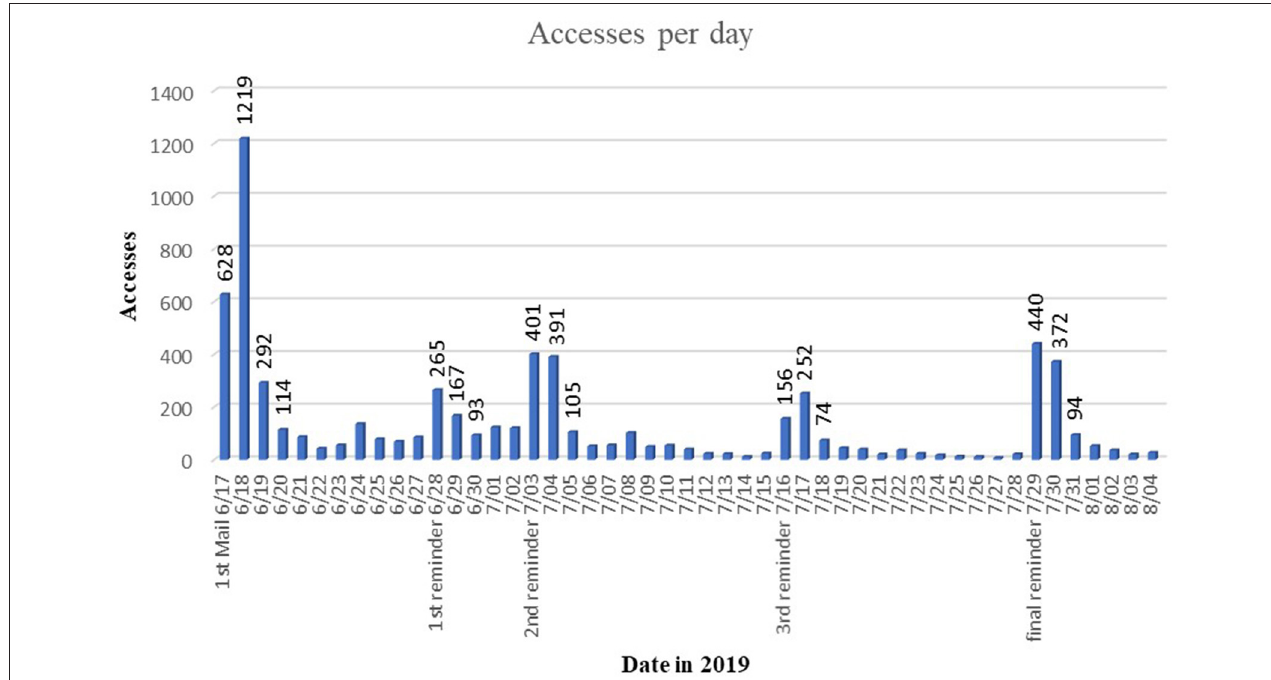
FIGURE 1 | Accesses to the online survey per day during the whole survey period.